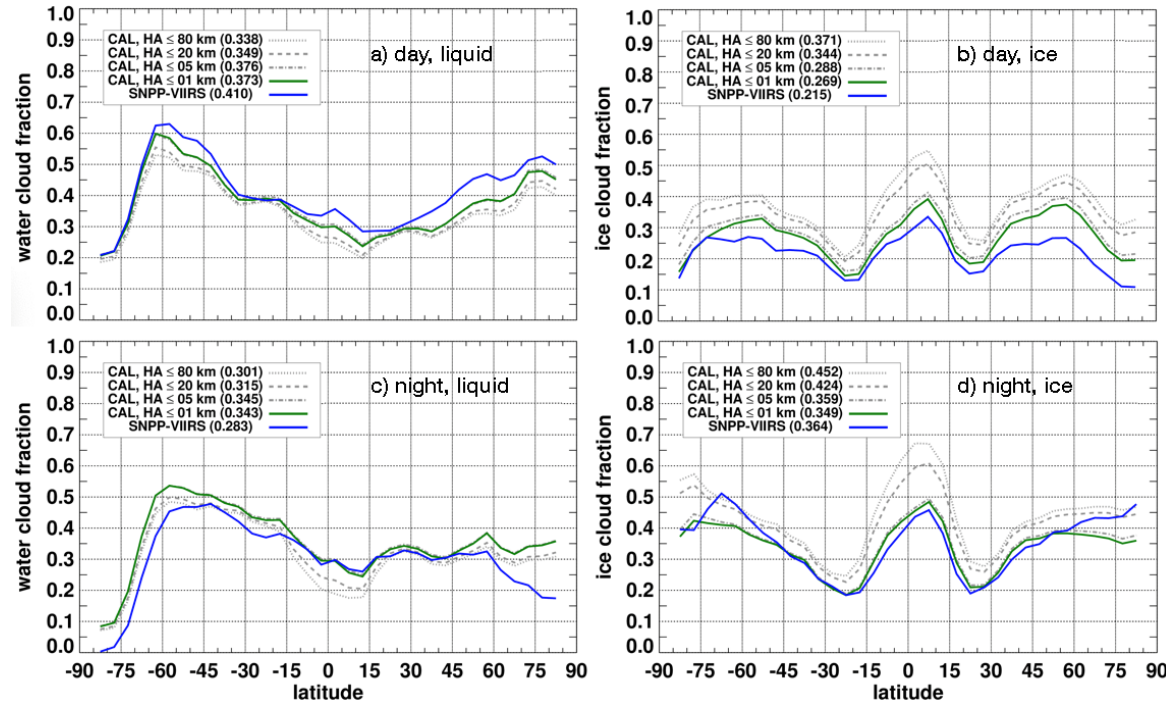
Figure 4. Average ( a,b ) daytime and ( c,d ) nighttime ( a,c ) liquid and ( b,d ) ice cloud amounts for CV1S and CALIOP pixels collocated within ±15 min, JAJO 2015–2016.